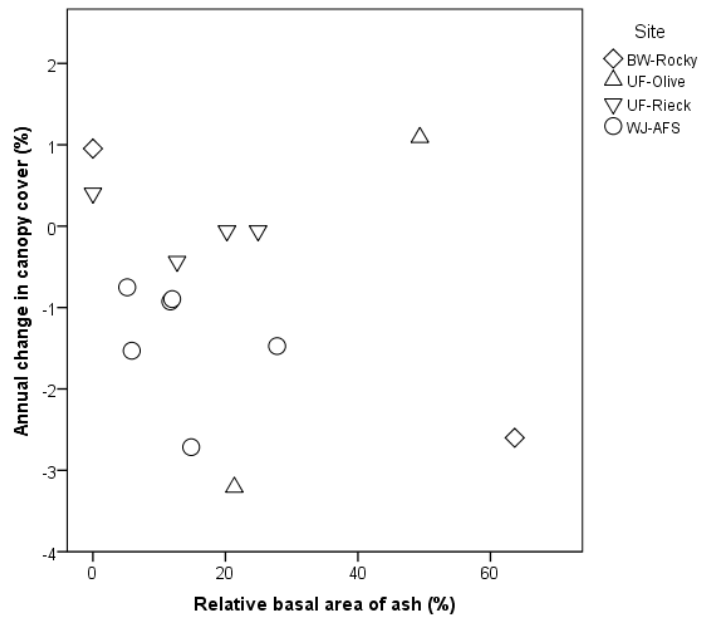
Figure 3. Mean annual change in canopy cover as a function of relative basal area of Fraxinus spp. prior to EAB invasion across four sites ( r 2 = 0.048, p = 0.450). AFS: Abernathy Field Station.